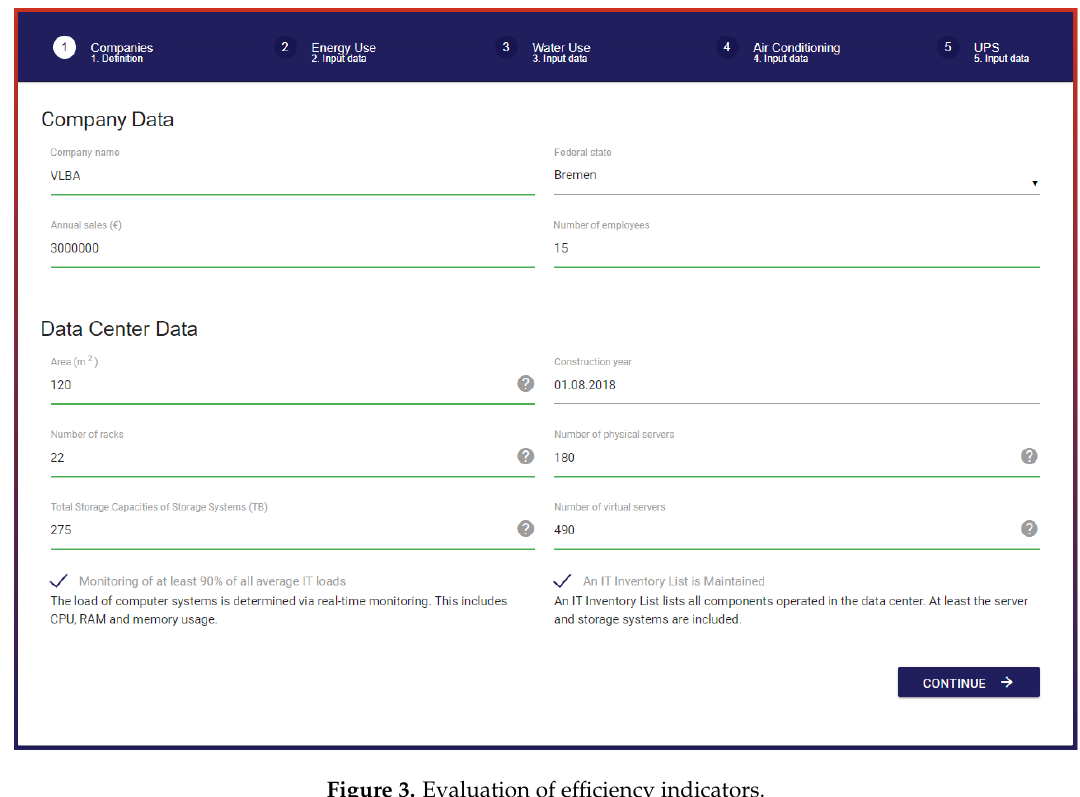
Figure 3. Evaluation of efficiency indicators.